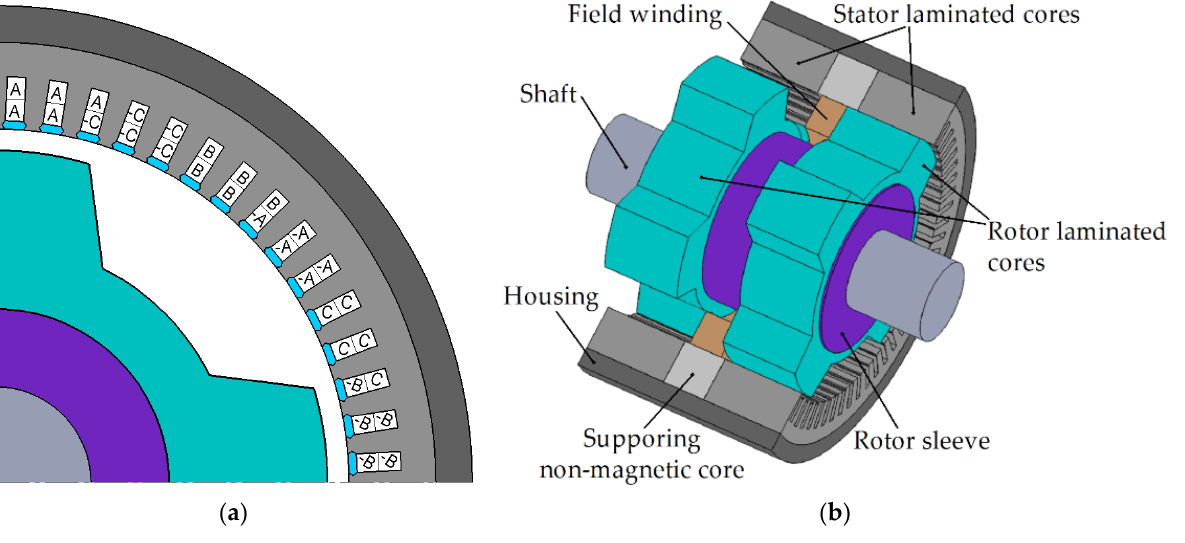
Figure 1. Sketch of the SHM geometry: ( a ) Cross-section and stator power winding configuration (1/4 of the motor cross-section is shown, the other parts are symmetrical). ( b ) General view. The stator winding is not shown to avoid cluttering up the figure.